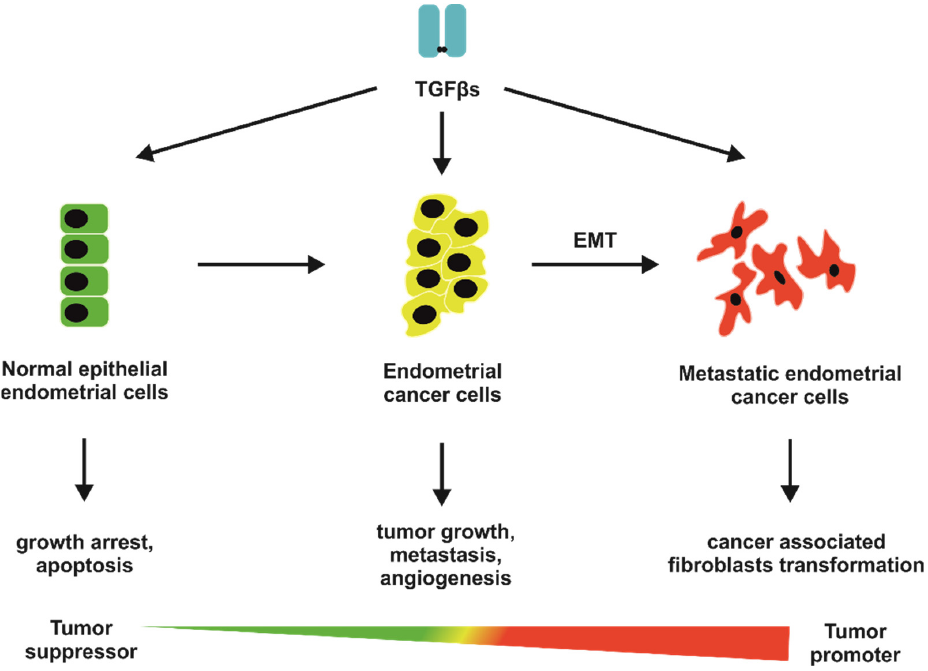
Figure 7. The pleiotropic role of TGF β signaling during endometrial